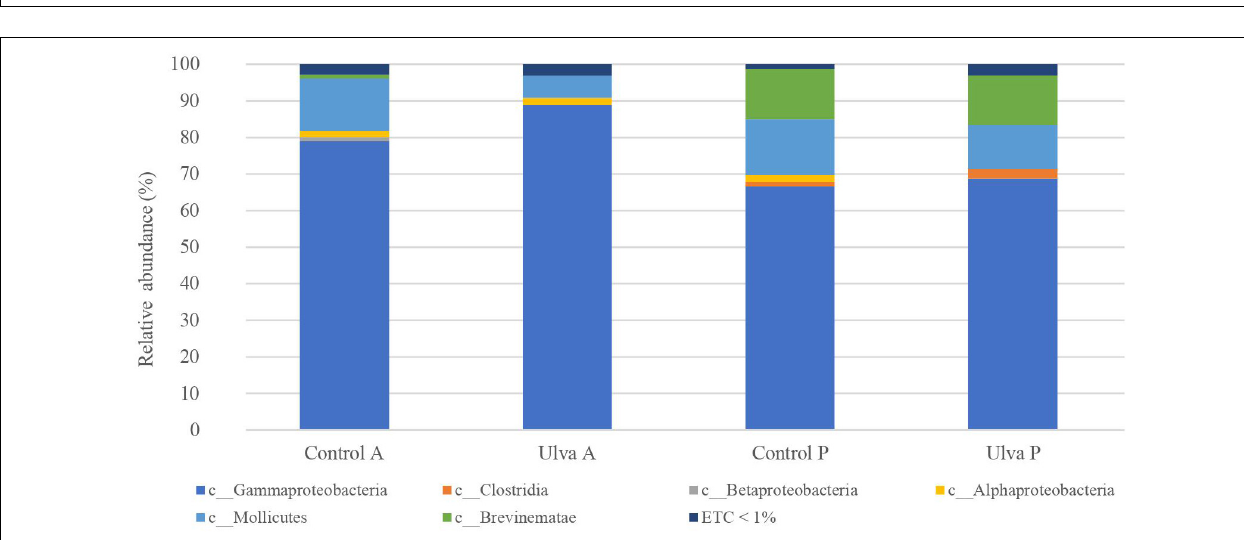
FIGURE 2 | Average of the samples of gut microbiota (relative OTU composition) at class level of the gastrointestinal tract of S. senegalensis fed control (Control) and Ulva ohnoi supplemented (Ulva) diet for 90 days. A, anterior section; P, posterior section. ETC < 1% indicates relative abundance below